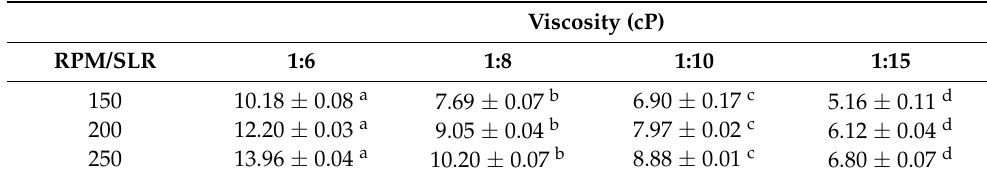
Table 1. Effects of SLR on slurry viscosity at different RPMs. Different letters within the same RPM row indicate statistically significant differences by one-way ANOVA followed by Tukey’s test at p <